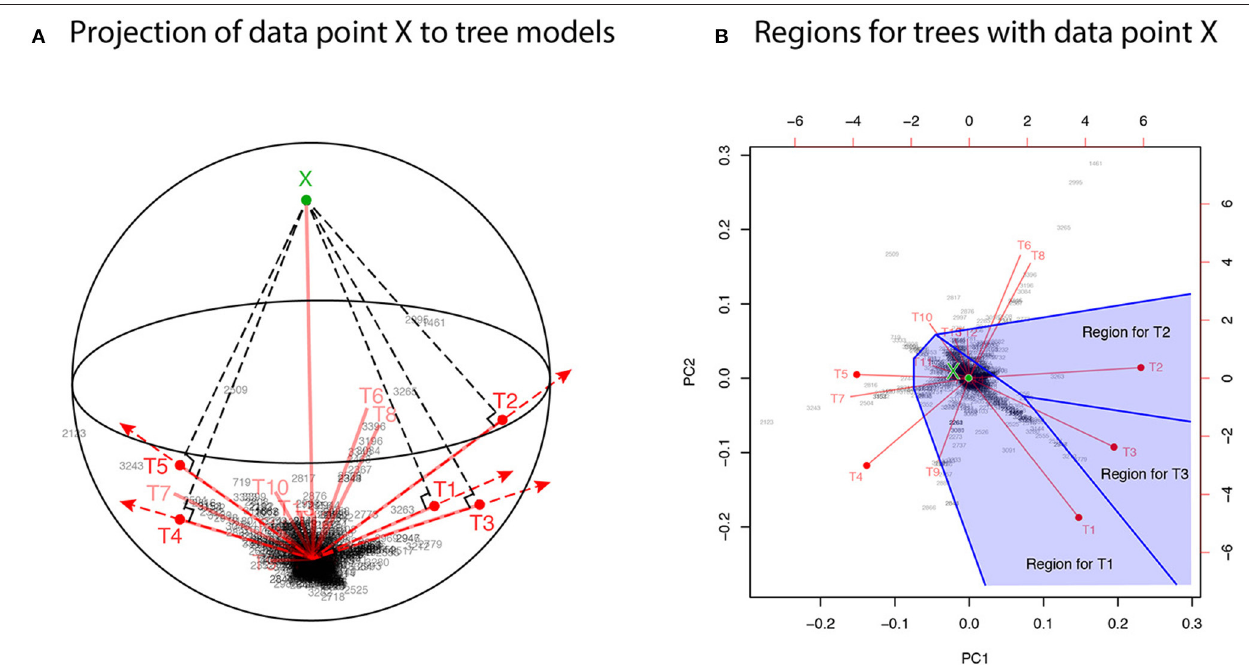
FIGURE 3 | Model map: Visualization of ML estimates of probability distributions for the best 15 trees. The origin represents the star-shaped tree topology (obtained by reducing the internal branches to zero length). Sites of amino acid sequences t = 1, ... , n (black numbers) and probability distributions for trees T1, ... ,T15 (red segments) are drawn by biplot of PCA. Auxiliary lines are drawn by hand. (A) 3-dimensional visualization using PC1, PC2, and PC3. The reconstructed data point X is also shown (green point). The ML estimates are represented as the end points of the red segments (shown by red points only for the best five trees), and they are placed on the sphere with the origin and X being placed at the poles. (B) The top-view of model map. Regions for the best three trees T i , i = 1,2,3 (blue shaded regions) are illustrated; T i will be the ML tree if X is included in the region for T i